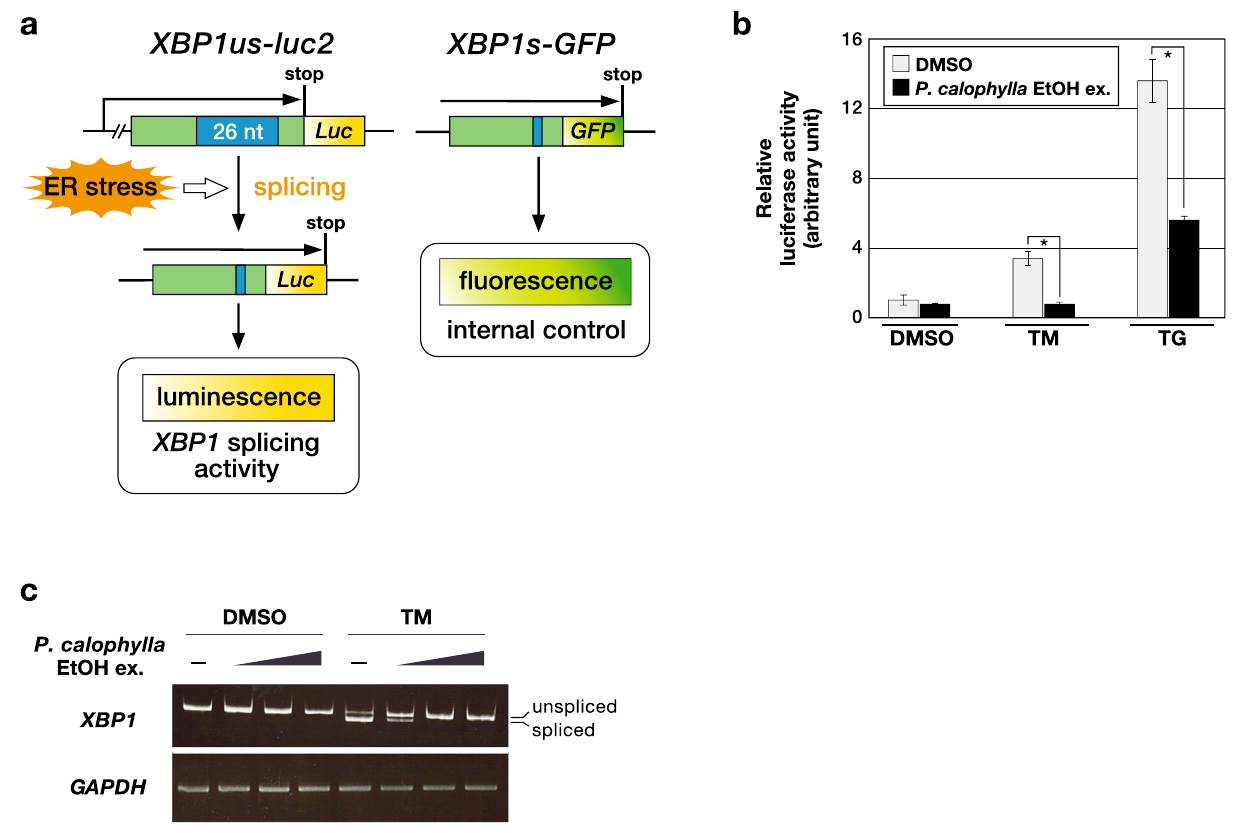
Figure 1. Ethanol extract of the P. calophylla stem inhibits activation of the IRE1-XBP1 pathway. ( a ) The scheme of the XBP1 splicing system ( XBP1us-luc2 and XBP1s-GFP ) in the reporter construct is shown. ( b ) HEK293 cells, stably expressing both XBP1us-luc2 and XBP1s-GFP , were pretreated with the ethanol extract of the P. calophylla stem ( P. calophylla EtOH ex.) (100 µg/ml) for 1 h, and were then incubated with tunicamycin (TM) (0.5 µg/ml) or thapsigargin (TG) (0.5 µM). DMSO was added as vehicle. After 6 h, luciferase activities and fluorescence intensities in cell lysates were measured. The luciferase activity was normalized by the fluorescence intensity. Values are shown as mean fold activity ± standard deviations (S.D.) ( n = 3 biological replicates). Statistical analysis was conducted between two groups with or without P. calophylla EtOH ex. for each TM or TG treatment assessed by two-tailed Student’s t -test, and the significant differences are indicated as * p < 0.05. ( c ) HEK293 cells were pretreated with the P. calophylla EtOH ex. in a dose-dependent manner (10, 30, 100 µg/ ml) for 1 h, and were then incubated with TM (0.5 µg/ml) for 6 h. The expression of each gene was assessed by RT-PCR. Unspliced or spliced XBP1 mRNA are indicated. GAPDH was used as the loading control. Uncropped images of gels are shown in Supplementary Information, Fig.